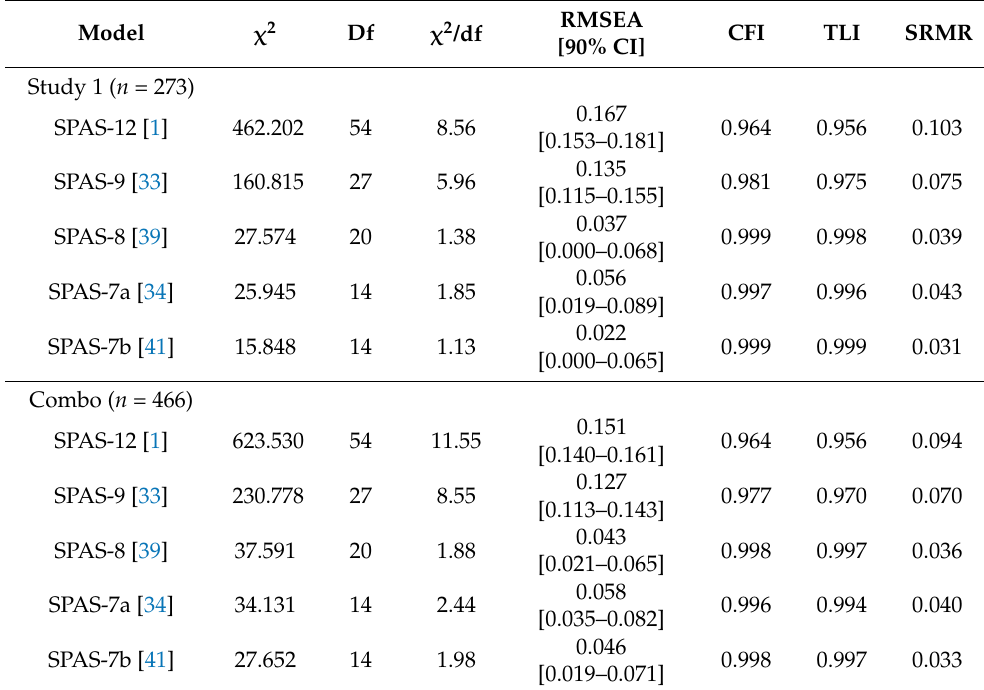
Table 2. Confirmatory Factor Analysis of the five versions of